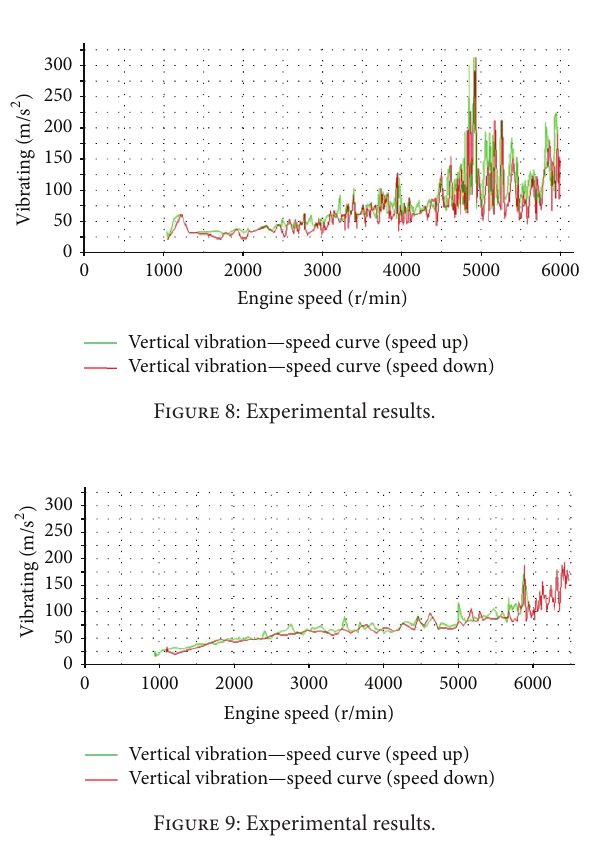
Figure 7: Experimental installation.